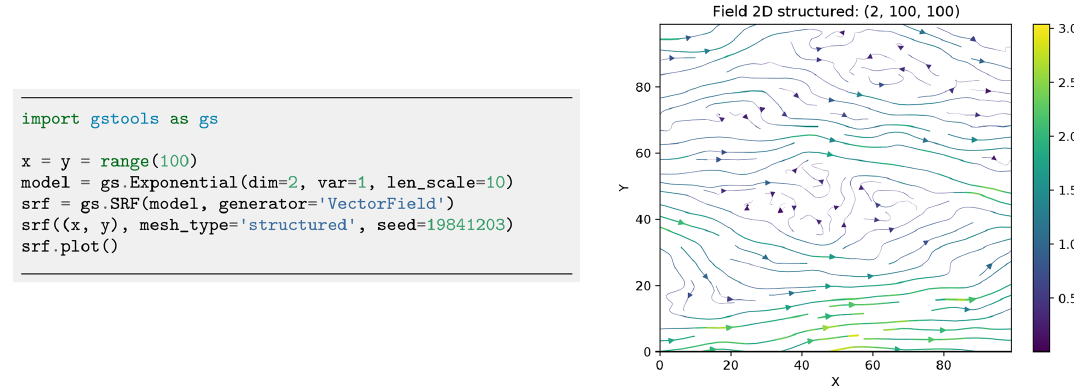
Figure 13. Generation of a structured incompressible random vector field with exponential variogram.